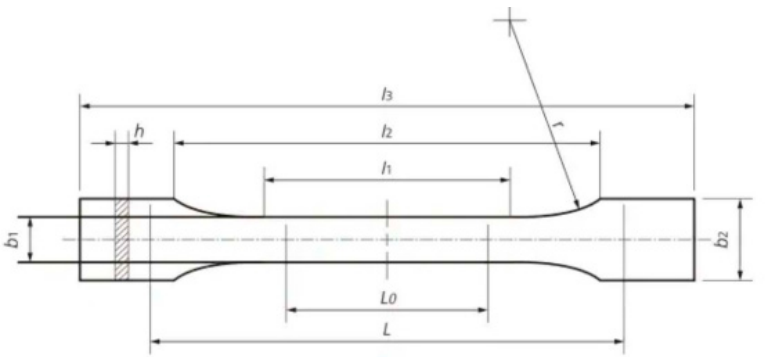
Figure 4. ASTM D638 IV standard test specimen design.